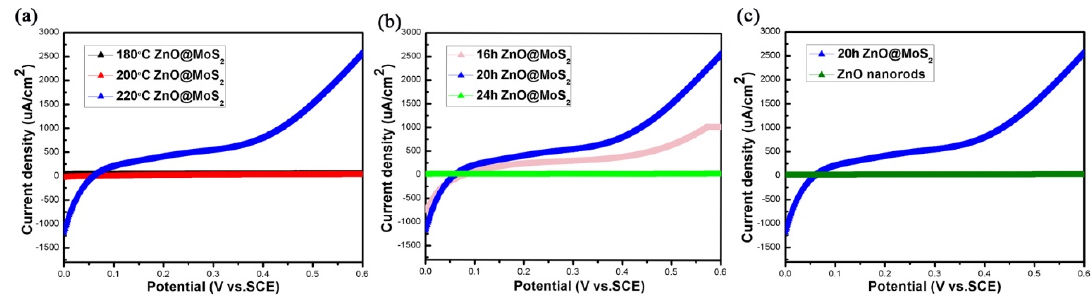
Figure 9. ( a – c ) LSV scanning of the prepared sample in a 0.1 M Na 2 SO 4 (pH = 6.8) electrolyte under a simulated sunlight of 100 mW/cm 2 with a scanning speed of 15 mV/s.